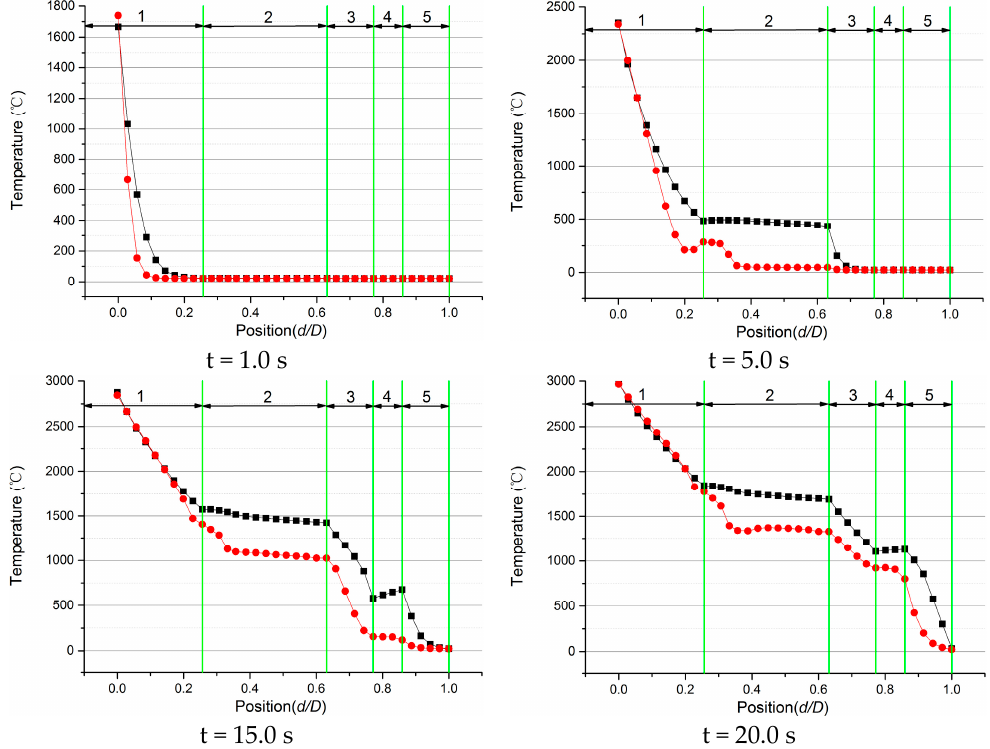
Figure 8. Temperature distribution graphs for the two types of interface treating methods. ( a ) The interfaces are treated as bonded ones; ( b ) the interfaces are treated as contact ones, where thermal contact resistance, radiation between the contact and the target, and energy dissipation caused by friction are effective.